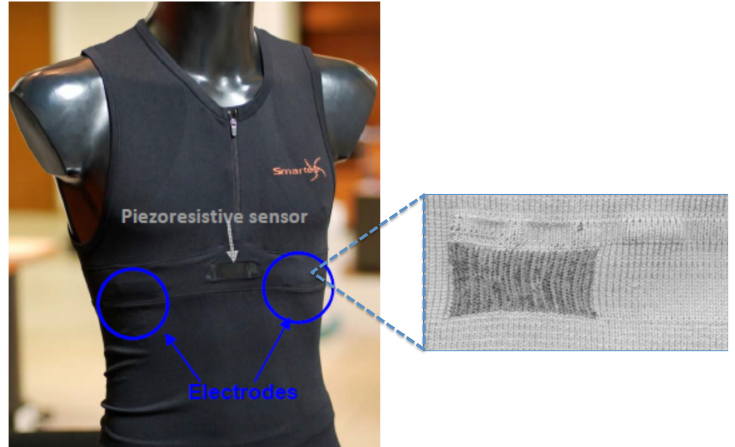
Figure 1. Wearable monitoring system for humans [48]. As is possible to note, from the box on the right, the e-textile electrodes for ECG (electrocardiographic) acquisition are knitted and completely integrated into the garment.